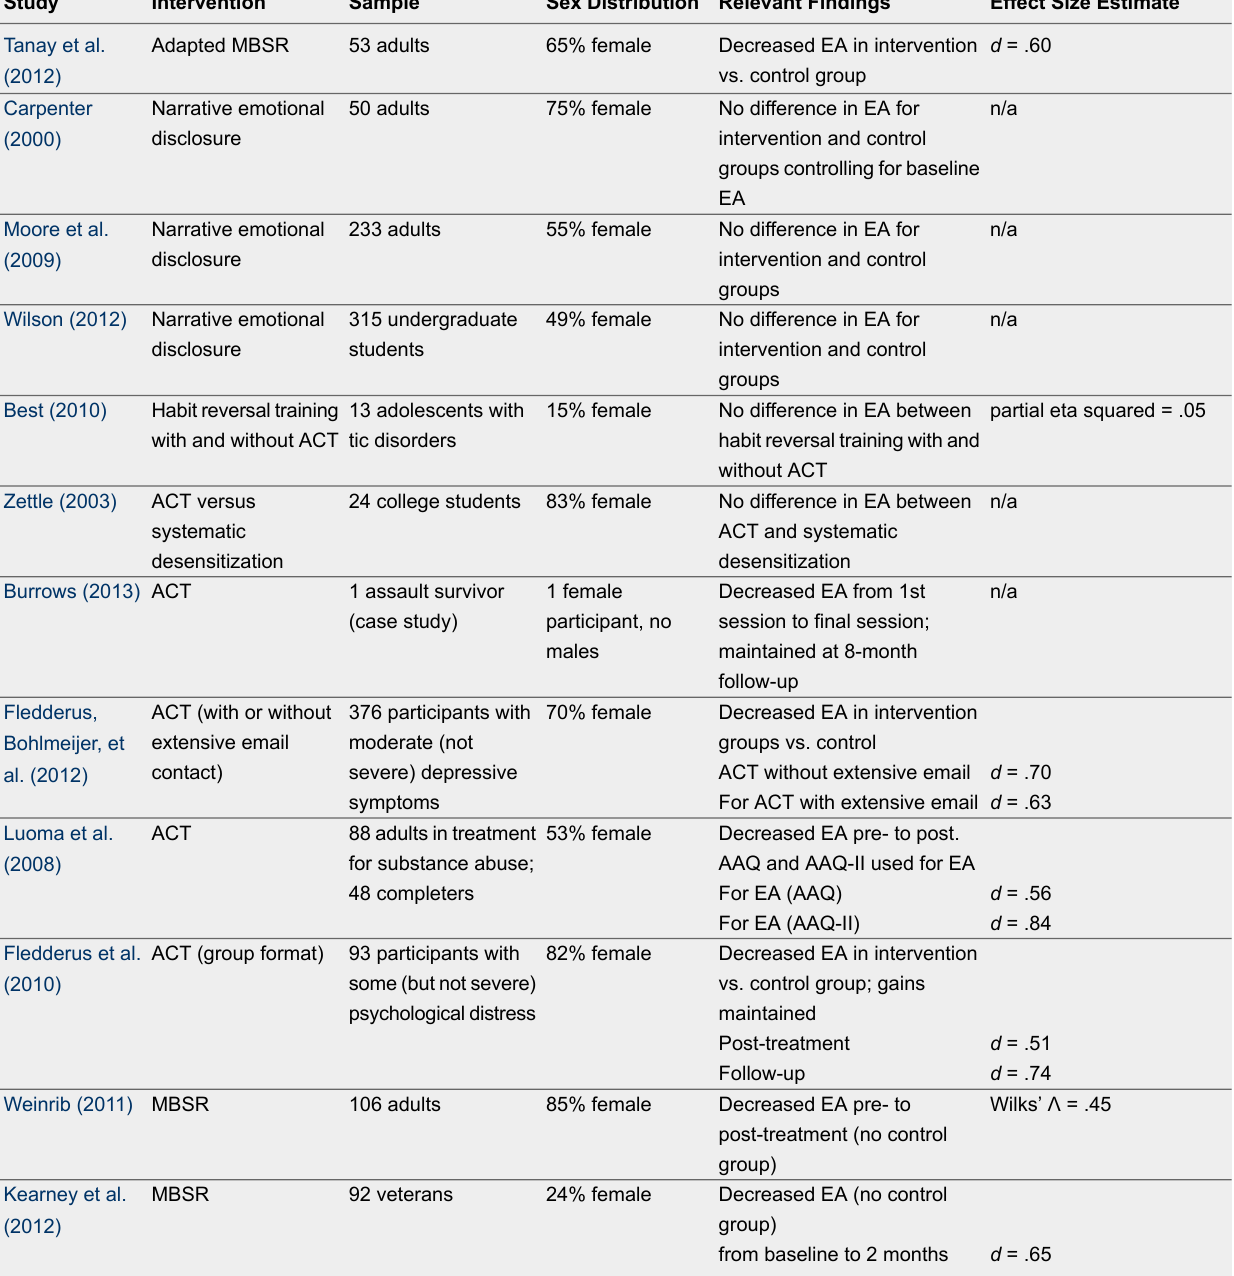
Summary of Psycho-Educational and Mindfulness-Based Interventions for